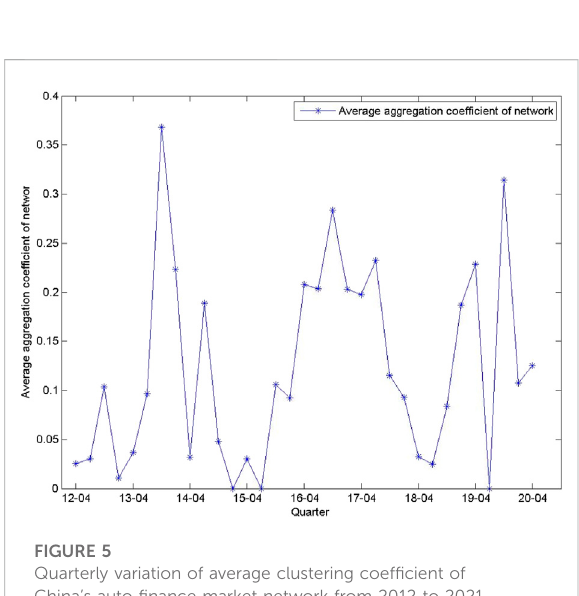
FIGURE 5 Quarterly variation of average clustering coef fi cient of China ’ s auto fi nance market network from 2012 to